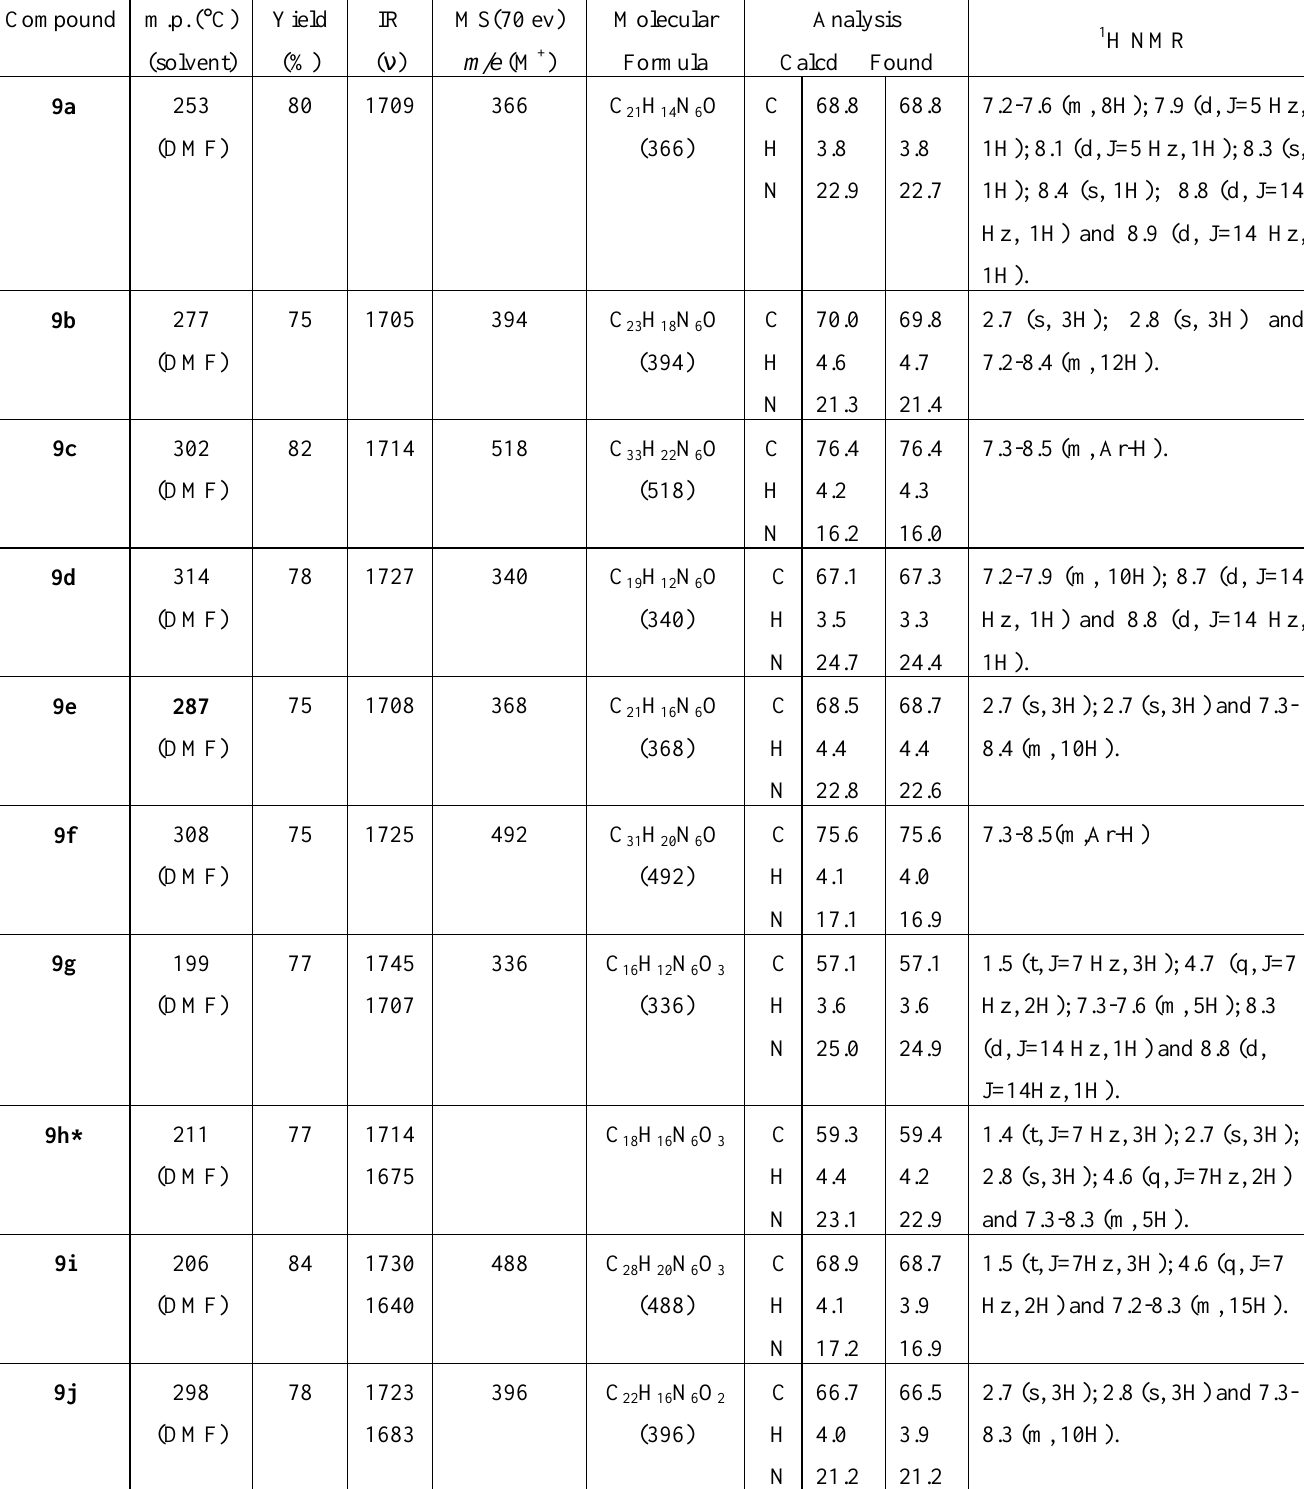
Table I. Physical and spectral data of new Triazolopteridines